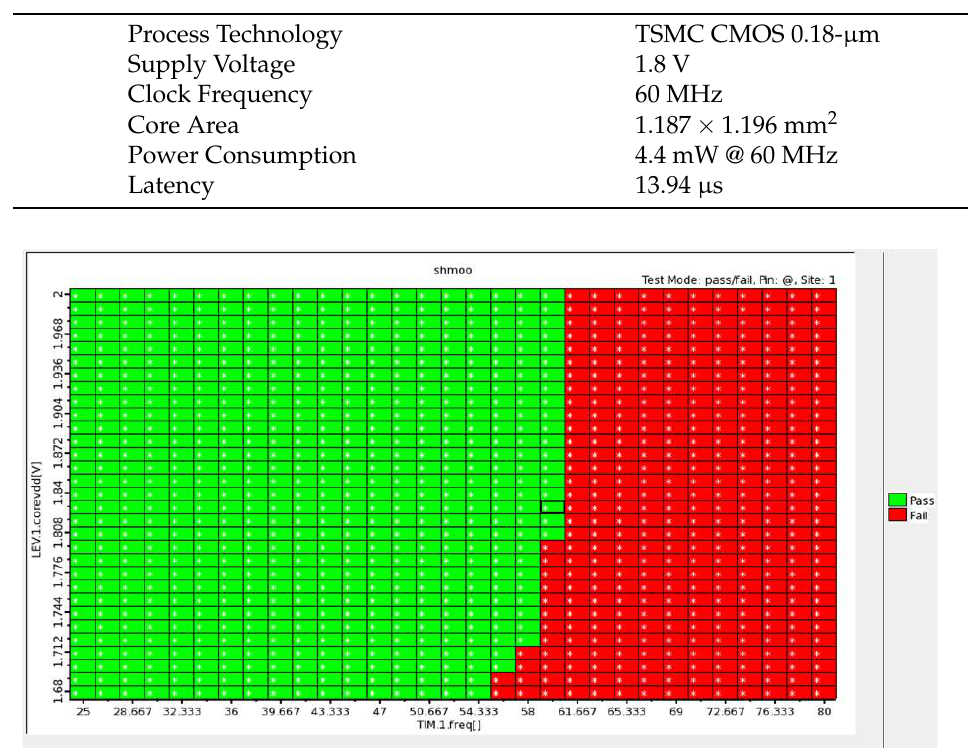
Figure 10. Shmoo plot of measurement results. Table 5. Performance comparison of the proposed circuit and a number of existing works